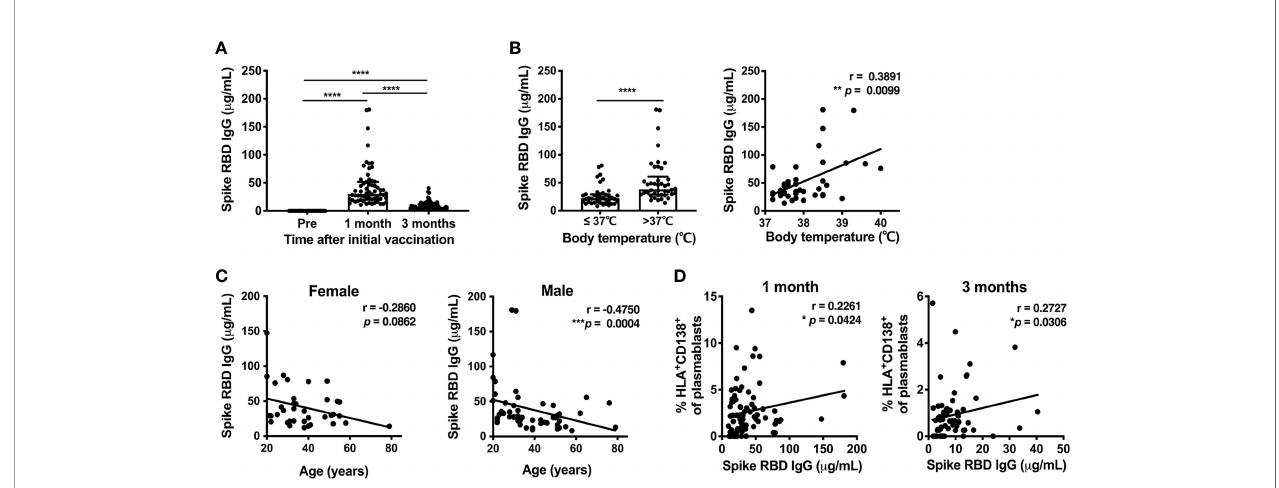
FIGURE 4 | SARS-CoV-2 mRNA vaccination-induced Spike RBD-binding IgG. Serum levels of SARS-CoV-2-Spike RBD-binding IgG were measured by ELISA. (A) Serum spike RBD IgG levels at 1 and 3 months after the fi rst dose of SARS-CoV-2 mRNA vaccine. For values below the lower limit of quanti fi cation (LLOQ), LLOQ/2 values are plotted. (B) The association of serum spike RBD IgG levels at 1 month after vaccination in individuals with post-vaccine fever. Left, comparison of spike RBD IgG levels between individuals with body temperature > or ≤ 37.0°C. Right, correlation between spike RBD IgG levels and body temperature in individuals with body temperature > 37.0°C. (C) Correlation between age and serum spike RBD IgG levels at 1 month post-vaccination. (D) Correlation between the percentage of HLA-DR + CD38 + plasmablasts and serum spike RBD IgG levels at 1 month (left) and 3 months (right) after vaccination. Each dot indicates the value of one individual. The box indicates the median and the whiskers indicate the fi rst and third quartiles (A, B) . *p<0.05, **p < 0.01, ***p < 0.001, ****p < 0.0001. p-values were determined by Wilcoxon matched-pairs signed-rank test ( A ), and Mann-Whitney U-test ( B , left). Correlations were analyzed using Spearman ’ s correlation test (B – D)